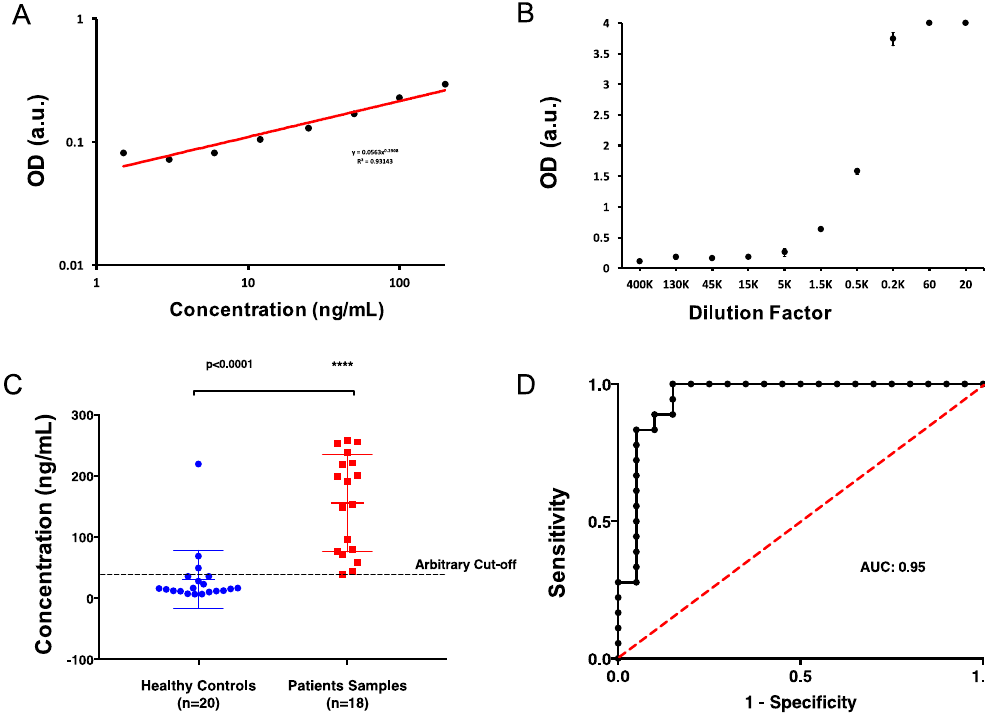
Figure 5. Validation of immunoassay test with clinical serum samples from 18 oropharyngeal cancer patients and 20 healthy controls. We performed our customized immunoassay test with clinical plasma samples from Oropharyngeal cancer patients. We have recorded the response of serially diluted patient sample (ID:02) in PBS. ( A ) Standard curve of the diluted patient sample. ( B ) Responses of varying dilutions (K: Thousand). Dilutions between 1.5 K and 0.2 K provided OD values within the linear range of the immunoassay. Therefore, 1:500 dilutions in PBS was used in the rest of the patient and healthy control samples. ( C ) We evaluated plasma samples from 20 healthy controls and 18 OPC patients. Patient samples have provided significantly high responses as compared to healthy controls. Controls have yielded false positive results too (particularly control ID:29). ( D ) We obtained ROC curve for our customized immunoassay test. Area under curve (AUC) of the system was 0.95 and the test had 94% sensitivity at 85% specificity. There was a significant difference between patient and control samples. Statistical analyses were performed using two-tailed Mann-Whitney test (n = 18, 20. P <